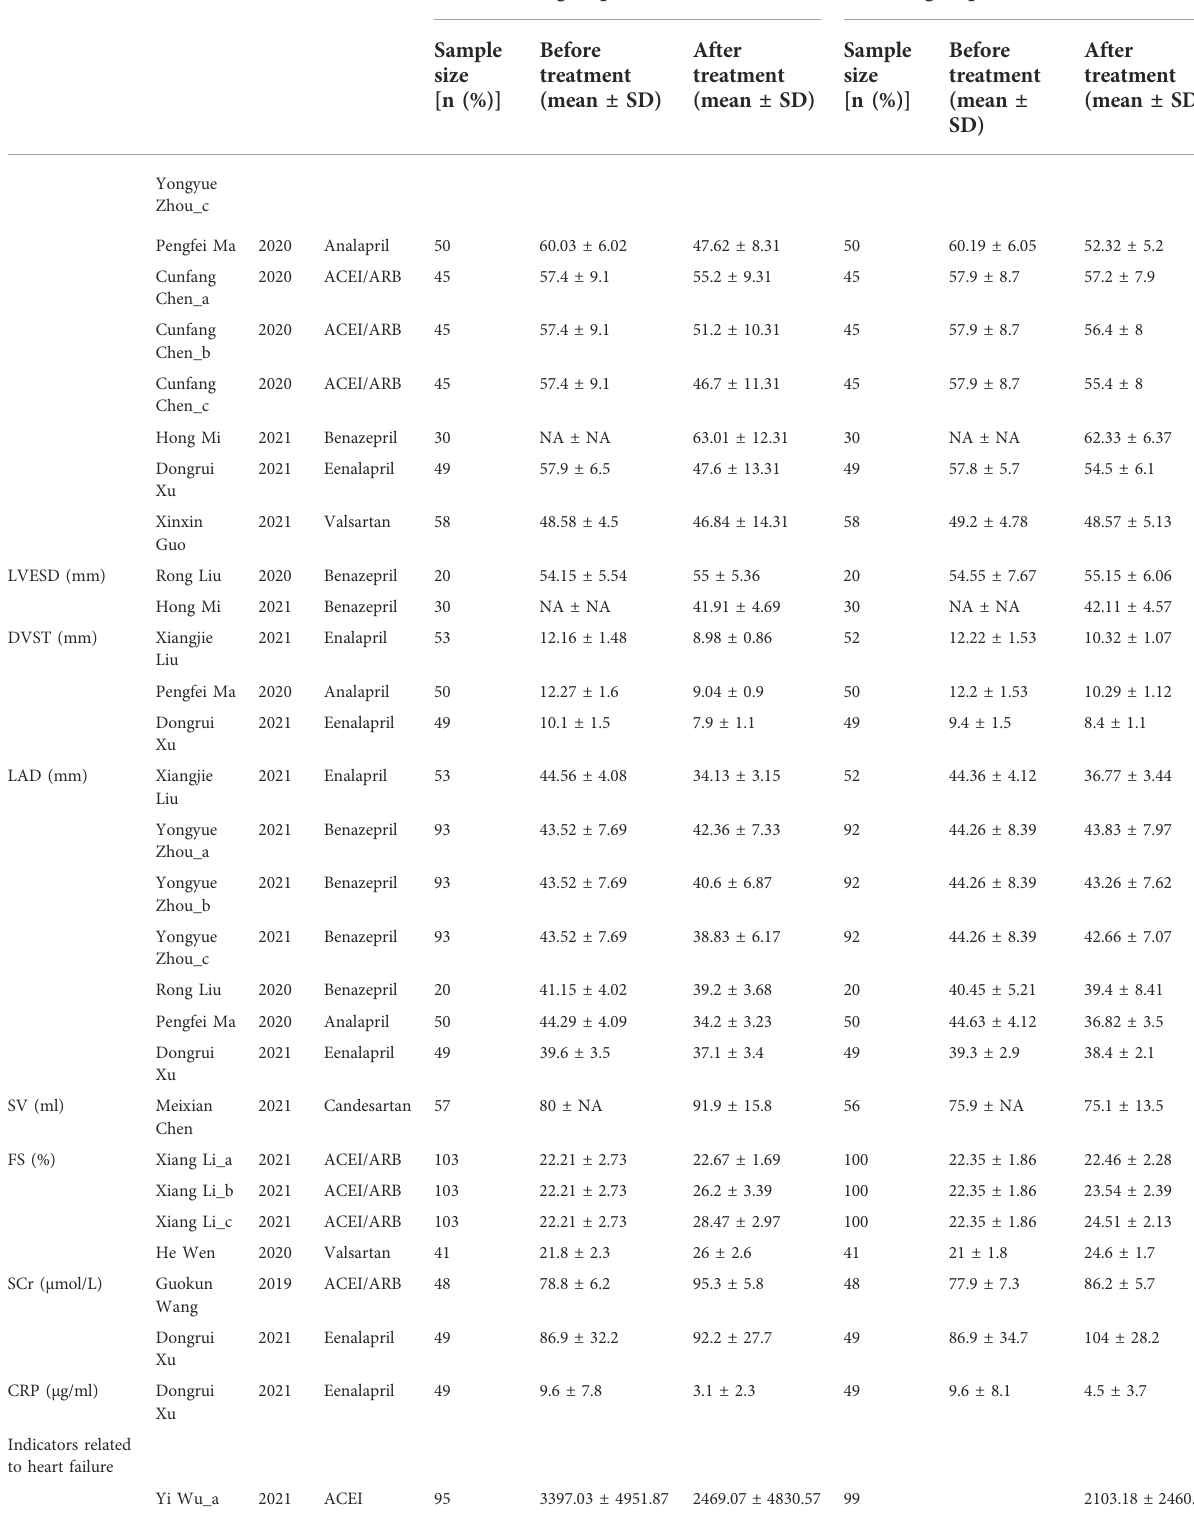
TABLE 2 ( Continued ) Left ventricular function outcomes before and after treatment between sacubitril-valsartan and ACEI/ARB